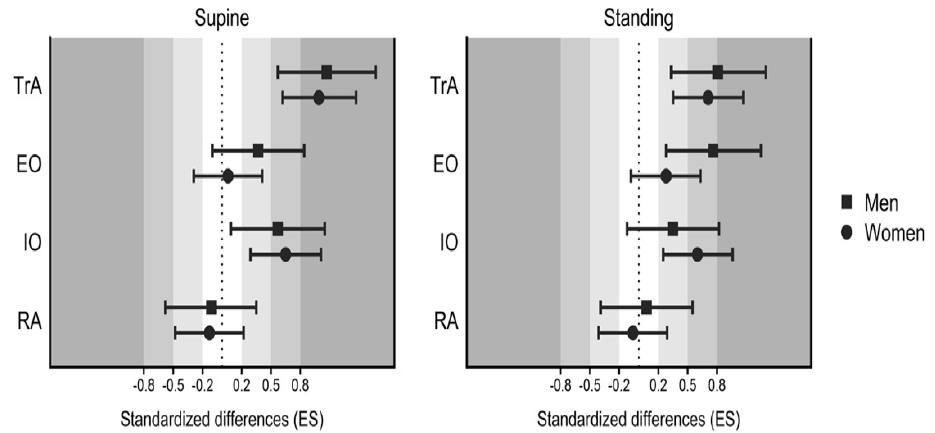
Figure 1. Standardized differences (Cohens ′ d) in abdominal thickness between rest and hypo- pressive exercise in both sexes in supine (left) and standing (right). TrA, transversus abdominis; IO, internal oblique; EO, external oblique; RA, rectus abdominis.